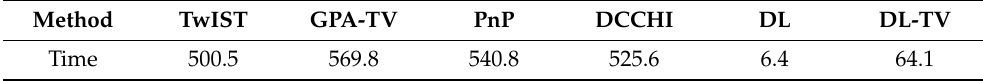
Table 6. Comparison of reconstruction time in seconds between different